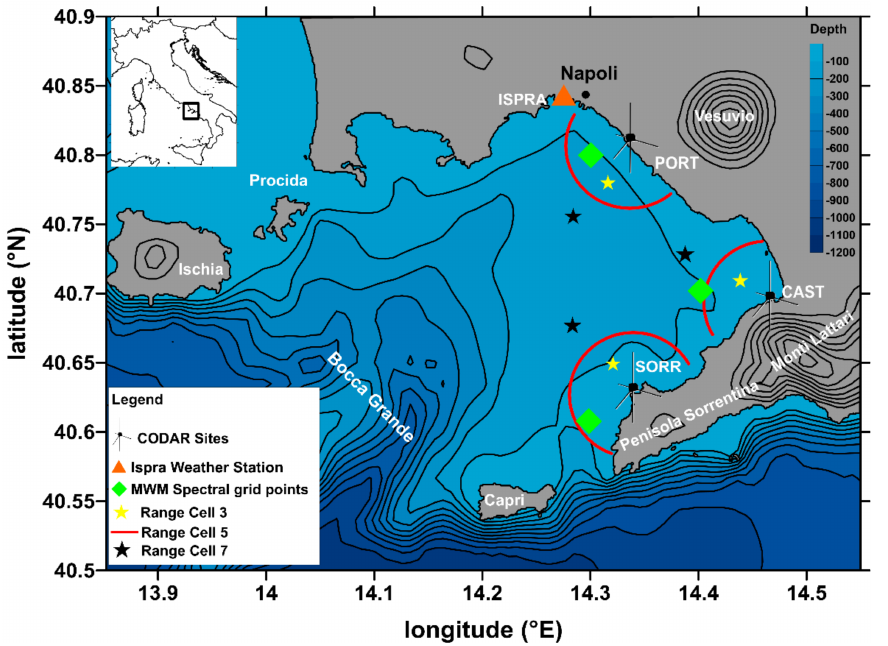
Figure 1. Map of the Gulf of Naples (Central Tyrrhenian Sea) with the locations of the three HF radar sites (antennas), ISPRA weather station (orange triangle) and the MWM model grid points of spectral data (green diamonds). The red semi-circles represent Range Cell 5 (RC5) of acquisitions, yellow stars represent Range Cell 3 (RC3) and black stars represent Range Cell 7 (RC7) offshore distances, respectively (see text). The bathymetric contours are spaced every 100 m; the orographic ones are spaced every 300 m. Coastline data: NOAA National Geophysical Data Center; Coastline extracted: WLC (World Coast Line); Date retrieved: 1 April 2015; http://www.ngdc.noaa.gov/mgg/shorelines/ shorelines.html, accessed on 8 September 2011; bathymetric and orographic data from